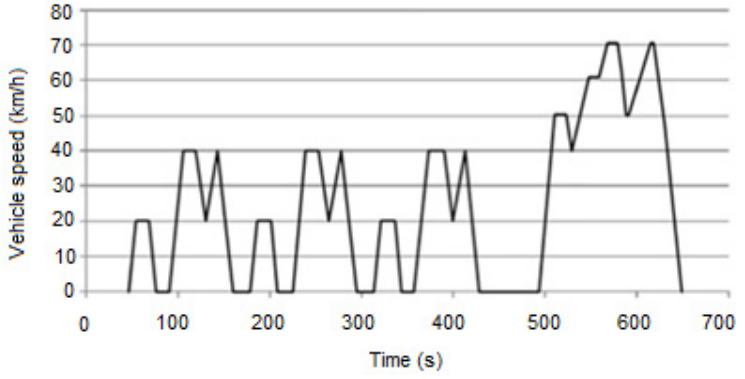
Figure 7. Evolution of speed versus time for the 10–15 protocol [4] (Reproduced with permission from Huicui et al. [4], Applied Energy; published by Elsevier Ltd., 2018).